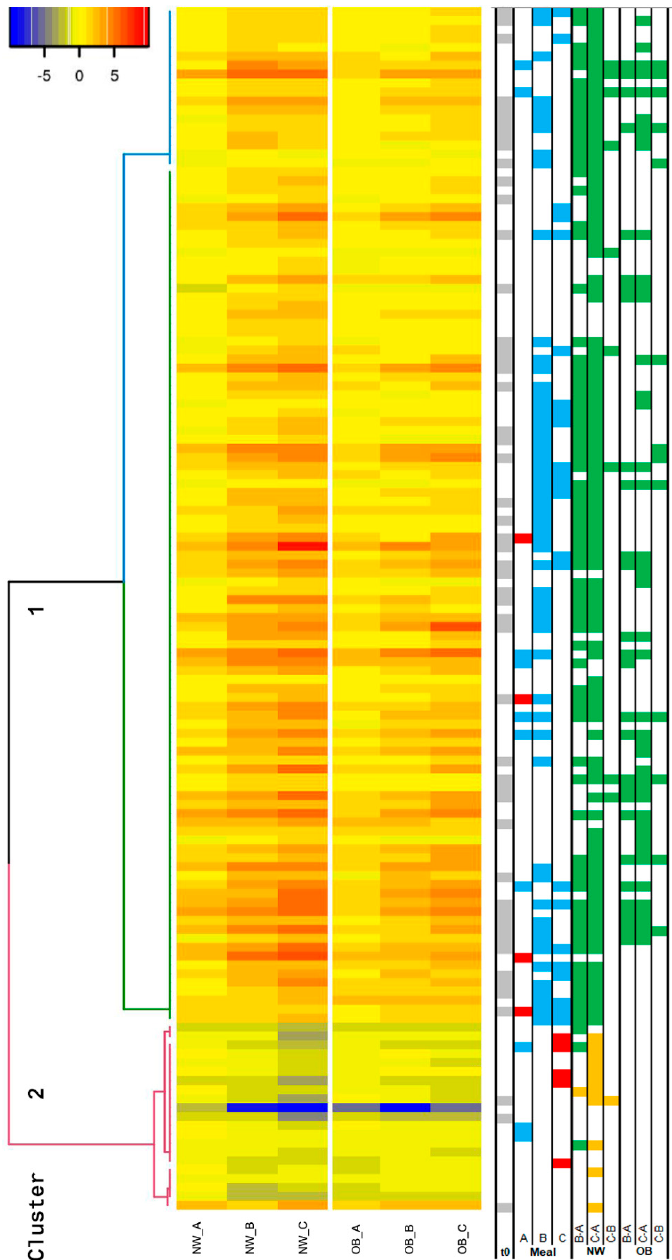
Figure 3. Postprandial iAUC results (0–6 h) of 135 dose-dependent features in 15 normal weight (NW) and 17 obese (OB) men after consumption of three HF meals (A = 500, B = 1000, C = 1500 kcal). Median values for all groups and each feature are shown. Significant ( p < 0.05) positive (cid:4) difference at fasting (t0) between OB and NW groups (Kruskal–Wallis rank sum test); Significant ( p < 0.05) positive (cid:4) or negative (cid:4) difference in iAUC between NW and OB groups for meal A, B, or C (Kruskal–Wallis rank sum test); Significant ( p < 0.05) positive (cid:4) or negative (cid:4) difference in iAUC between different caloric doses B-A, C-A, or C-B for NW and OB groups (Kruskal–Wallis rank sum